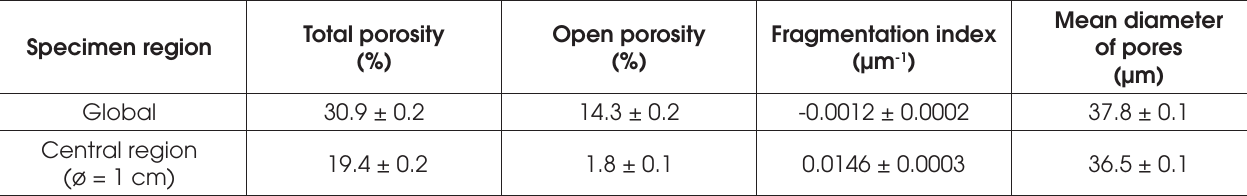
Quantity of materials per dosage mix Specimen